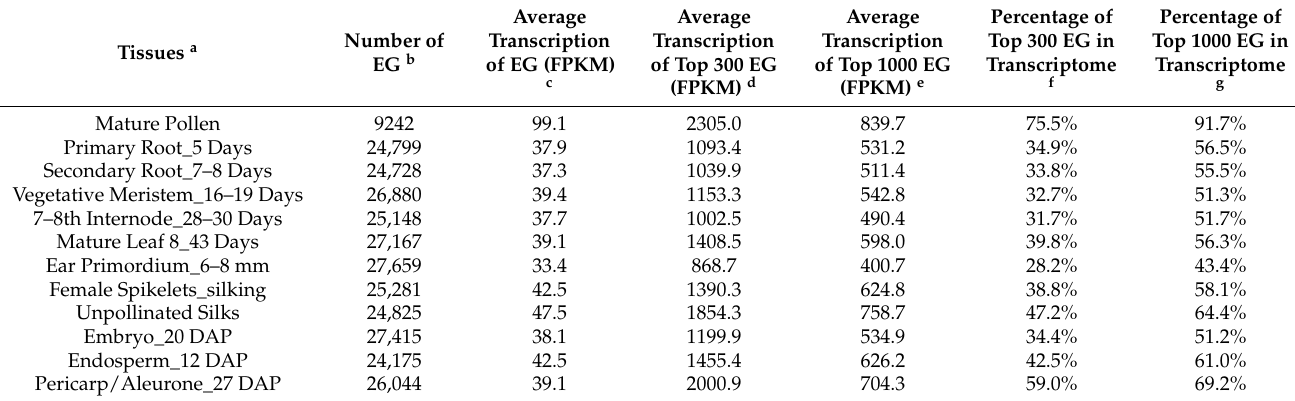
Table 1. Expressed Genes (EG) and average transcriptional levels of top 300 EG and top 1000 EG in 12 selected maize tissue types. Number of Tissues a EG b Mature